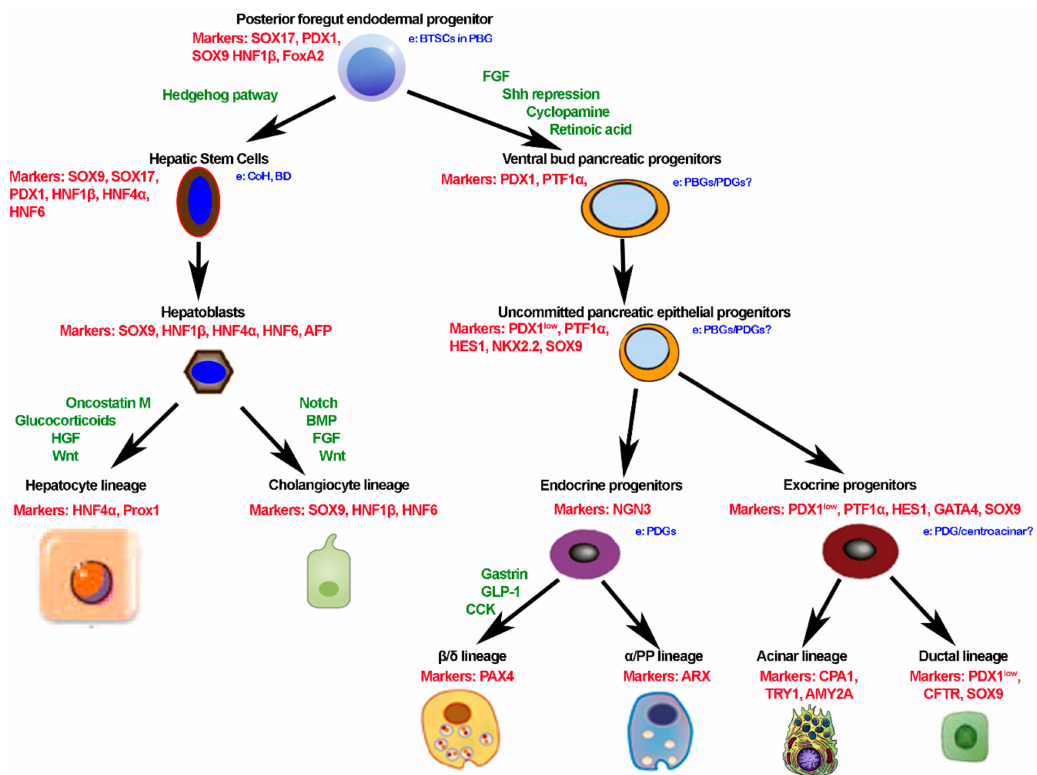
Figure 2. Maturation of hepatic, biliary, and pancreatic lineages from foregut endoderm progenitor cells. In the figure we recapitulate the embryological development, indicating key biomarkers and stimuli to induce cell di ff erentiation. Abbreviations (in order of appearance): a, adult; e, embryonic; BTSCs, biliary tree stem / progenitor cells; PBGs, peribiliary glands; PDGs, pancreatic ductal glands; CoH, canal of Hering; BD, bile duct; AFP, alpha-fetoprotein; AMY2A, amylase 2A; CPA1, carboxypeptidase A1; SOX, sex determining region Y-box; PDX1, pancreatic and duodenal homebox 1; HNF, hepatocyte nuclear factor; Fox, forkhead box; PTF, pancreas transcription factor-like; HES1, transcription factor HES1; NGN, neurogenin; GATA, erythroid transcription factor; PAX, paired box; ARX, aristaless related homeobox; TRY, transcription factor TRY; CFTR, cystic fibrosis transmembrane conductance regulator; CPA, carboxypeptidase; FGF, fibroblast growt factor; Shh, sonic hedegehog; HGF, hepatocyte growth factor; BMP, bone morphogenetic protein; GLP-1, glucagon like peptide 1; IGF-1, insulin-like growth factor